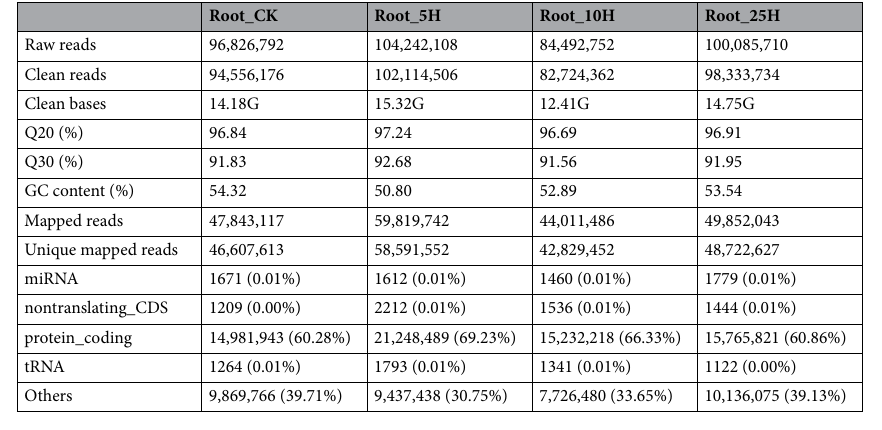
Table 1. Sequencing data and mapping information of the four libraries used in this